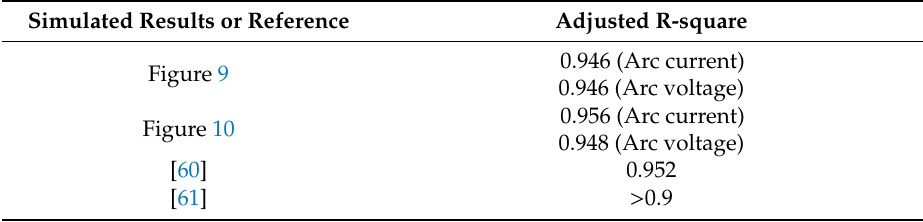
Table 4. Comparison between the simulation results and other references